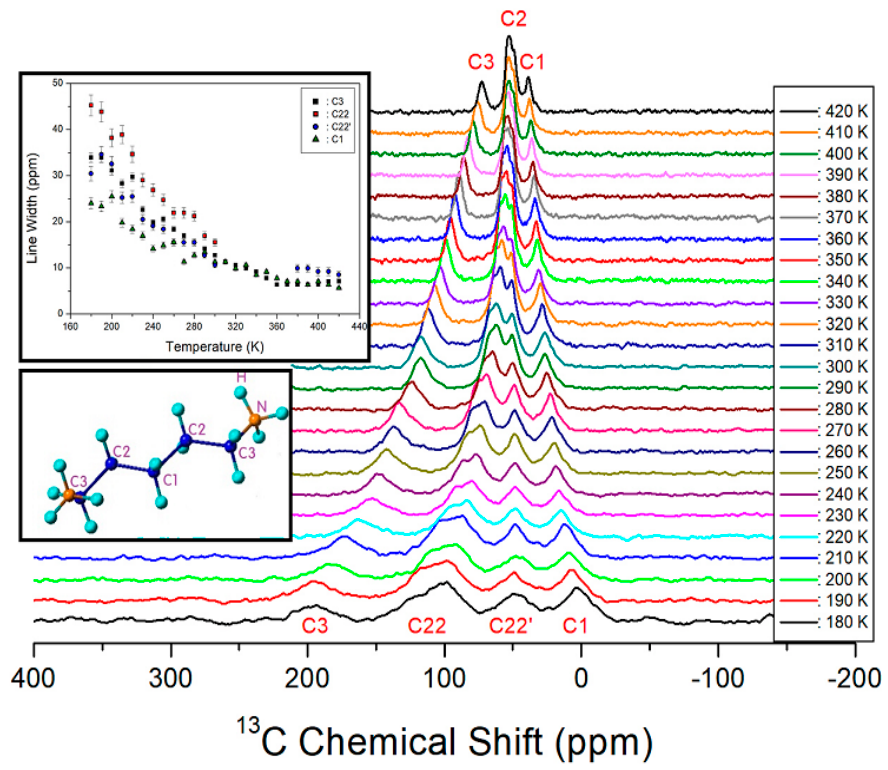
Figure 5. MAS 13 C NMR spectra of [NH 3 (CH 2 ) 5 NH 3 ]CuCl 4 as a function of temperature.